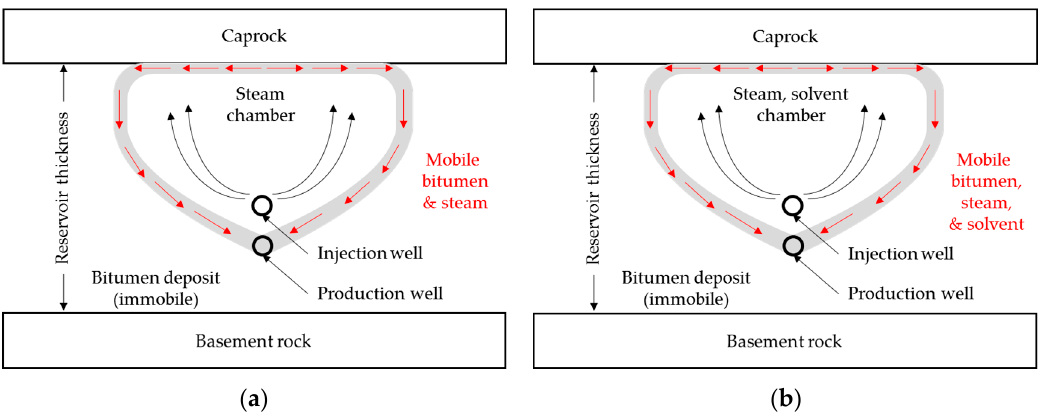
Figure 1. Schematics of Steam Assisted Gravity Drainage (SAGD) and Expanding Solvent–SAGD (ES-SAGD): ( a ) SAGD; and ( b )